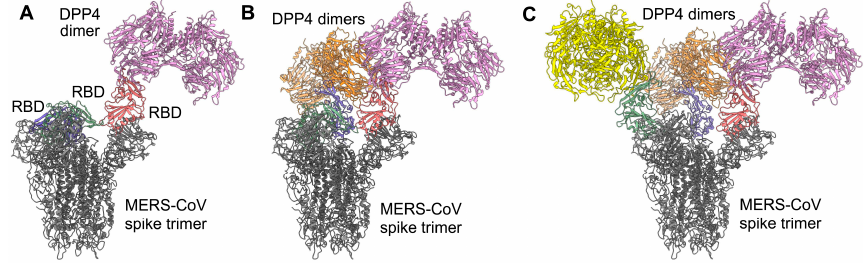
Figure 3. Models of the MERS-CoV S-protein trimer bound to DPP4. The models were generated by superimposing the MERS-CoV RBD in the structure of the MERS-CoV S-protein RBD–DPP4 complex (PDB ID: 4KR0) onto the RBDs in the structures of MERS-CoV S-protein trimers with ( A ) one RBD (PDB ID: 5X5F), ( B ) two RBDs (PDB ID: 5X5C), or ( C ) three RBDs (PDB ID: 5X59) in the “standing” conformation. The MERS-CoV S-protein trimers are colored in gray, with three RBDs colored in red, blue, and green. Three DPP4 dimers are colored in plum, orange, and yellow. DPP4, dipeptidyl peptidase 4; PDB, protein data bank; RBD, receptor-binding domain; S, spike protein.